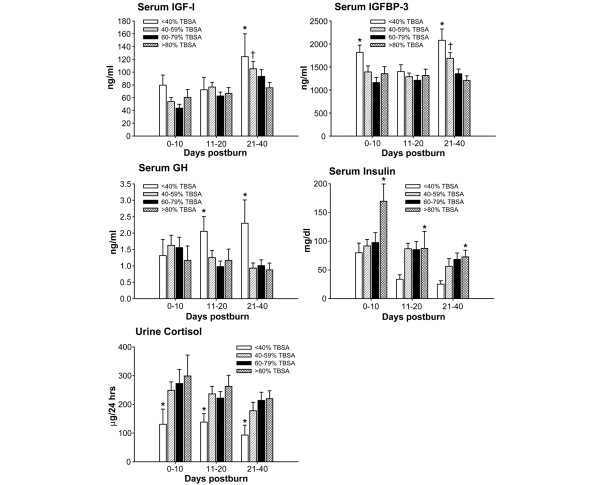
Serum protein concentrations during acute hospitalization at multiple time points. Serum insulin growth factor-I (IGF-I) was significantly increased in the <40% and 40–59% total body surface area (TBSA) burn groups compared with the 60–79% and >80% TBSA burn groups 21–40 days postburn. At the later time point, serum insulin like growth factor binding protein-3 (IGFBP-3) was significantly higher in the <40% and 40–59% TBSA burn groups when compared with the other two burn groups. Serum growth hormone (GH) markedly decreased in burns of >40% TBSA and was significantly higher in burns of <40% TBSA. Serum insulin was significantly increased in large burns immediately after burn compared with the small burns. Urine cortisol was increased during the acute stay in all four groups. Urine cortisol, however, was significantly lower in the <40% TBSA burn group when compared with the other three groups. *Significant difference between >80% TBSA burn group versus <40% TBSA burn group, P < 0.05. †Significant difference 60–79% TBSA burn group versus <40% TBSA burn group, P < 0.05. Normal levels: IGF-I, 220–260 pg/ml; IGFBP-3, 3,800–4,200 pg/ml; GH, 6 pg/ml; insulin, 10–25 mg/dl; and urine cortisol, 20–45 μg/24 hours.